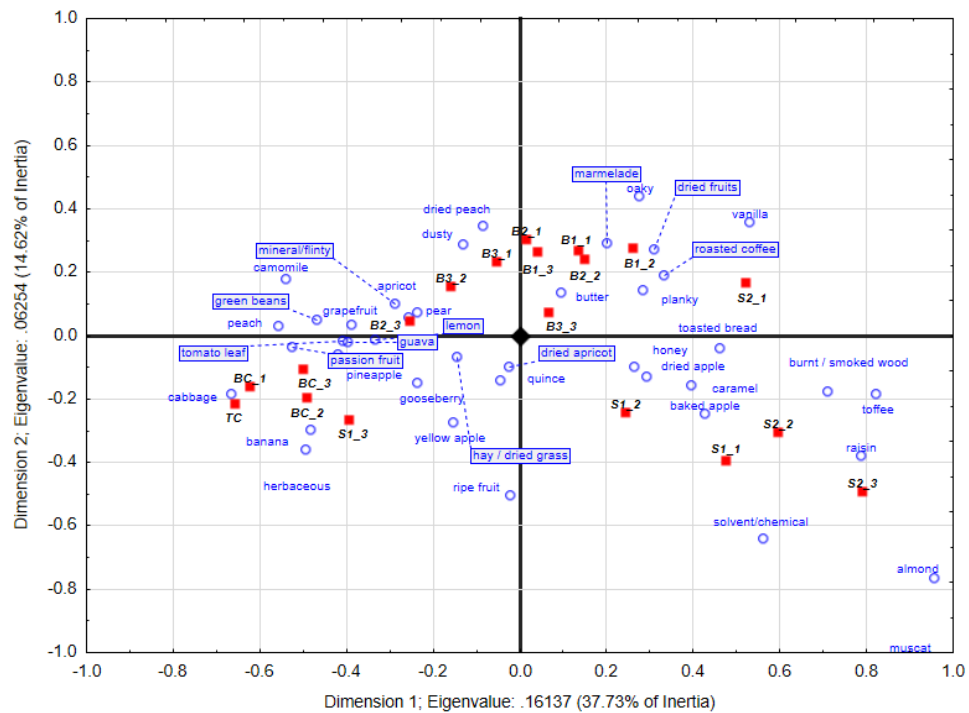
Figure 3. Correspondence analysis obtained with the trained panel ( n = 20) after 9 months of oak maturation and 6 months bottle ageing from Pick K data. Certain descriptors (boxed) have been moved to improve the readability of the plot. TC: tank control, BC: barrel control, B: new barrel treatments, S: stave treatments.